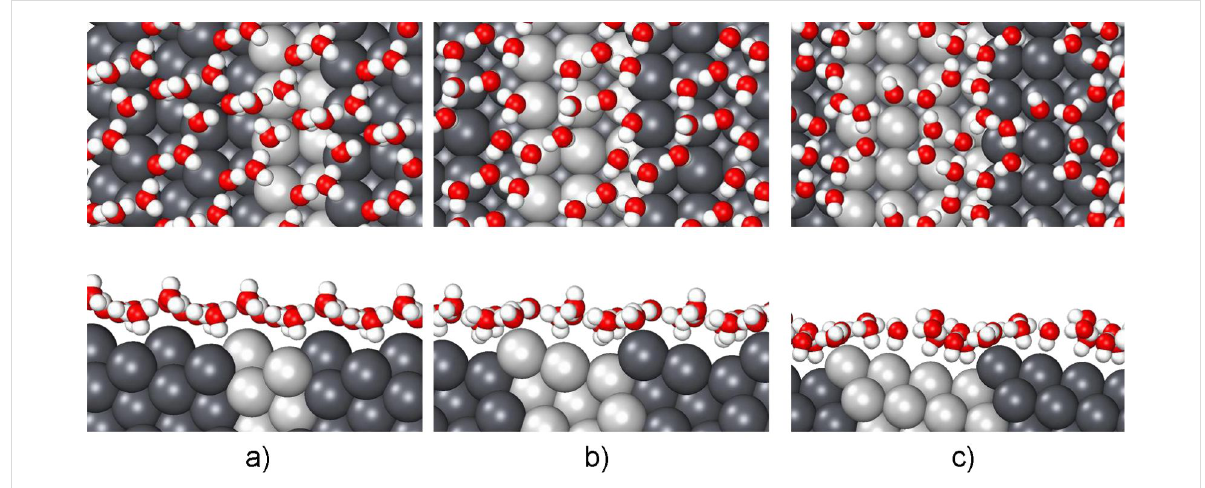
Figure 3: Top and side views of the energetically most stable water structures on Pb(311) (a), Pb(511) (b) and Pb(711) (c).